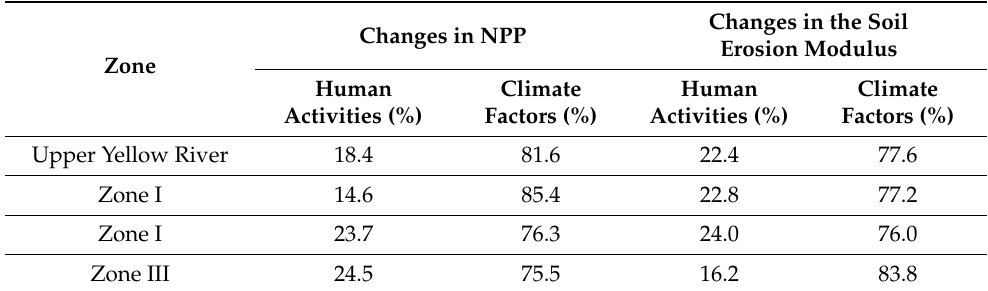
Table 7. Contribution rates of human activities and climate factors to NPP and soil erosion modulus changes from 2000 to 2019.